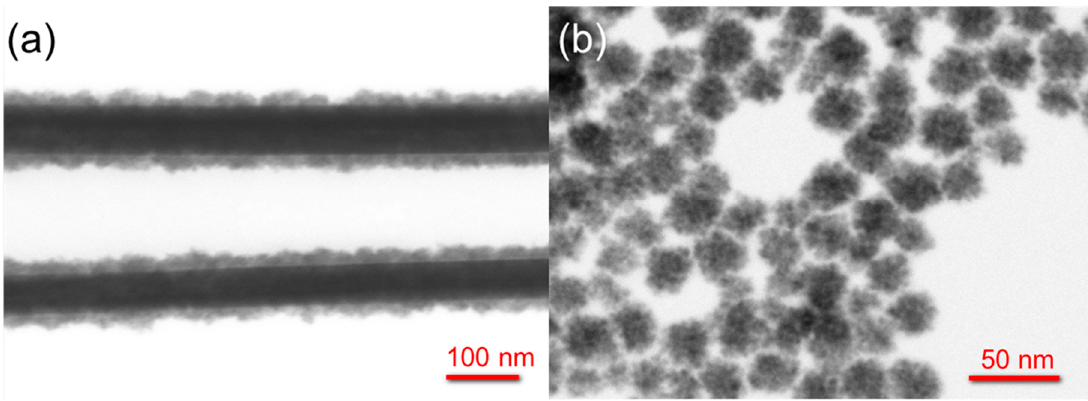
Figure 1. STEM images of ( a ) core/shell Ag/SnO 2 NWs and ( b ) SnO 2 NPs.